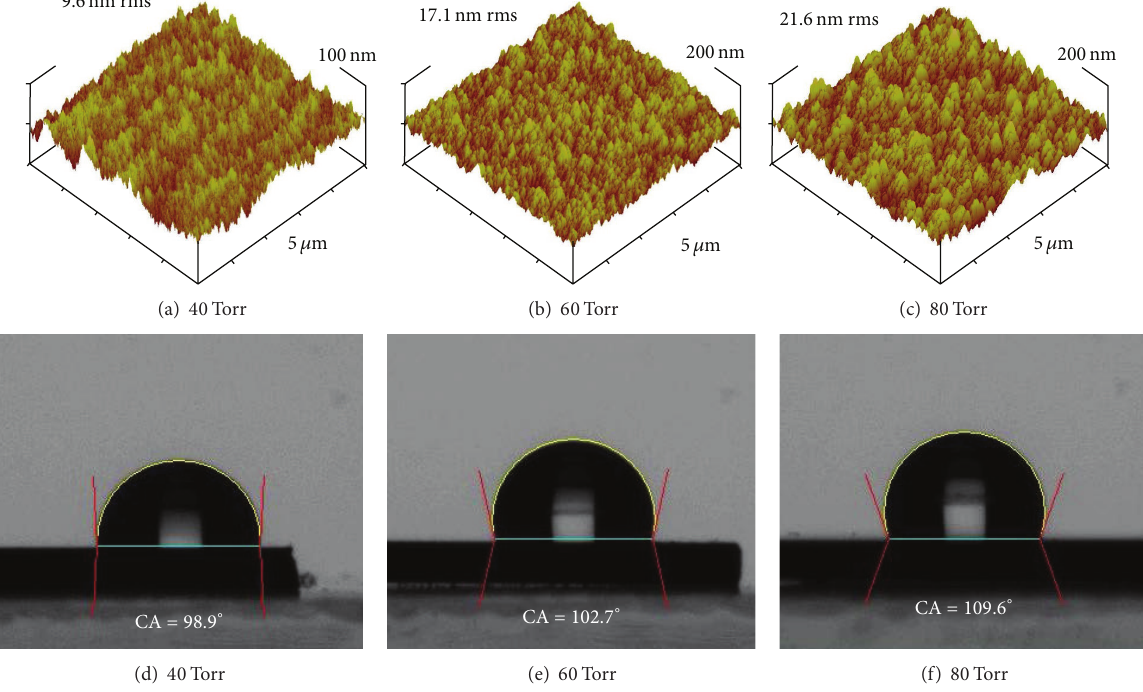
Figure 3: The surface roughness and contact angle values with water for the diamond films grown under various working pressures of 40, 60, and 80 Torr,